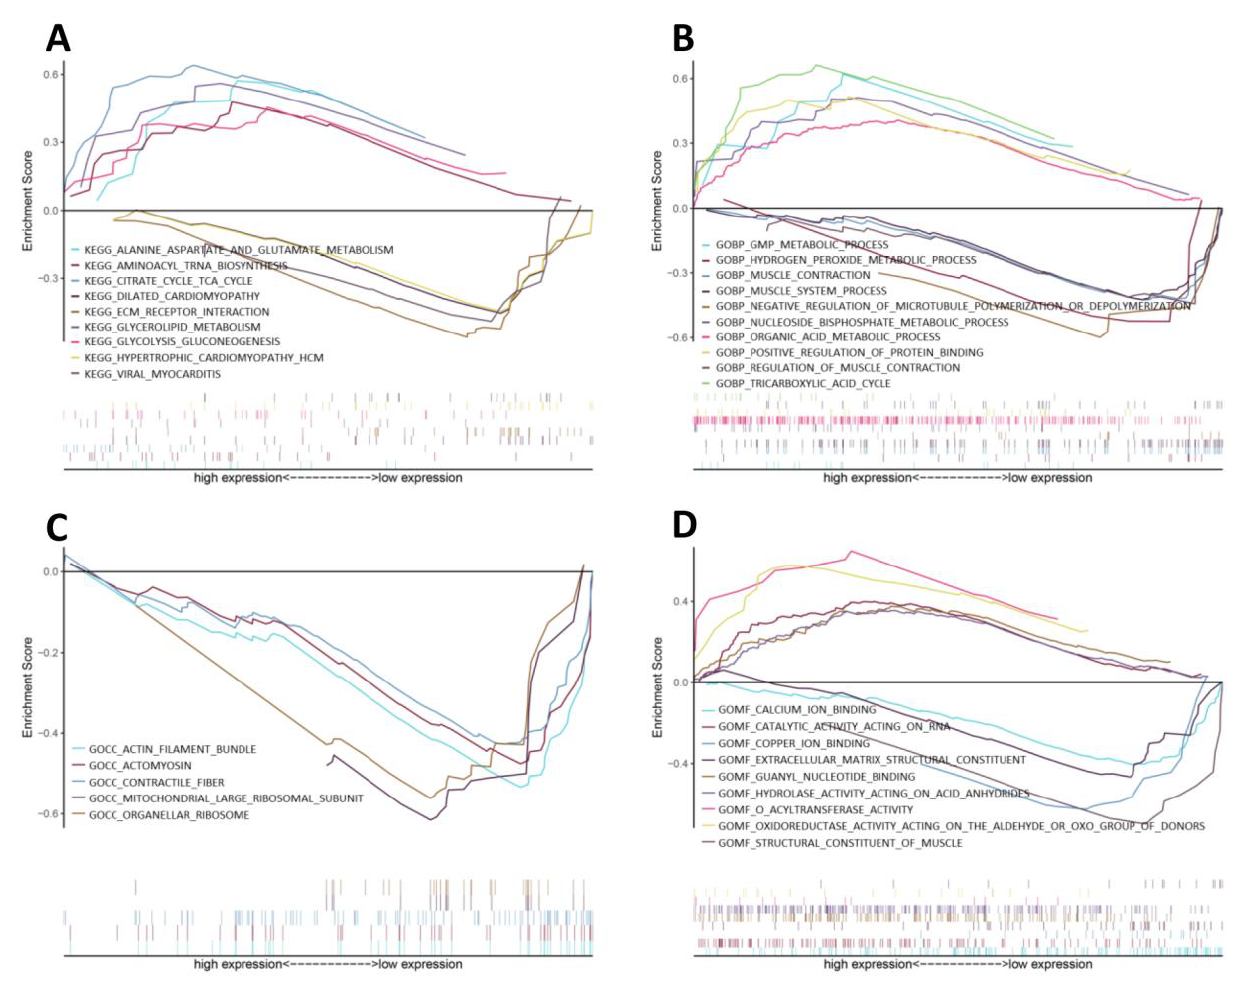
Figure 2. GSEA of CIP-stimulated VSMCs. GSEA results for the activation of ( A ) KEGG pathways, ( B ) biological processes, ( C ) cellular components and ( D ) molecular functions in CIP-stimulated VSMCs compared with control VSMCs.